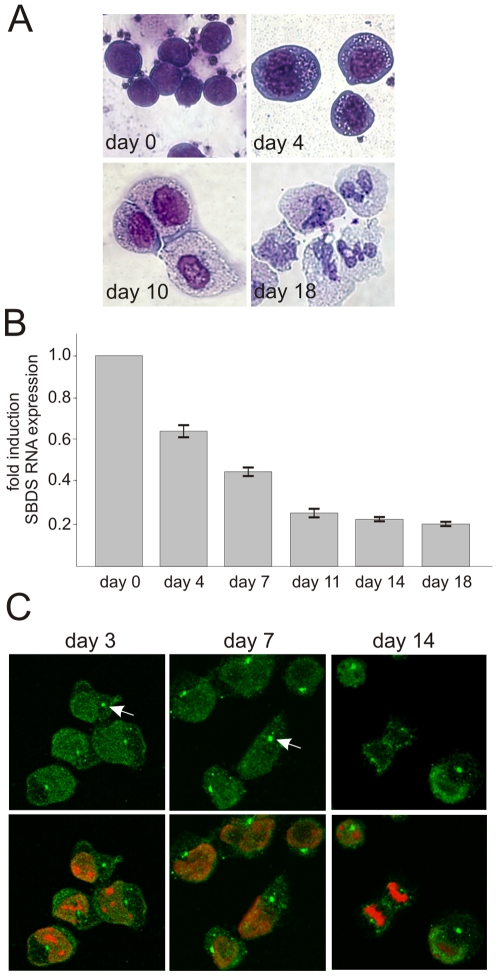
SBDS expression is downregulated during human cord blood CD34+ neutrophil differentiation.Human CD34+ cord blood cells were differentiated towards neutrophils with a cocktail of cytokines over a period of 18–21 days. (A) May-Grünwald-Giemsa staining on differentiating CD34+ cells shows that these cells are acquiring morphological characteristics of neutrophilic cells during the culture. (B) Representative quantitative RT-PCR analysis shows that SBDS mRNA expression decreases 5-fold with human cord blood neutrophil differentiation (n = 3; mean±SEM). (C) Immunofluorescence staining for SBDS in differentiating cord blood hematopoietic progenitor and neutrophilic cells shows that SBDS protein is localized predominantly in the nucleus and to a lower extent in the cytoplasm. In all cells a prominent SBDS-enrichment is observed in the perinuclear region (indicated with arrow). In mitotic cells, we observed that SBDS is localized at the mitotic spindle and/or centrosomes during the anaphase of mitosis (right panel).